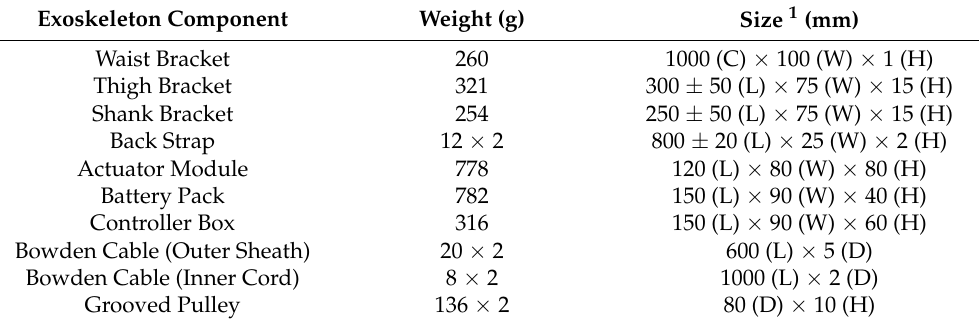
Table 1. Weights and dimensions of the major exoskeleton components.